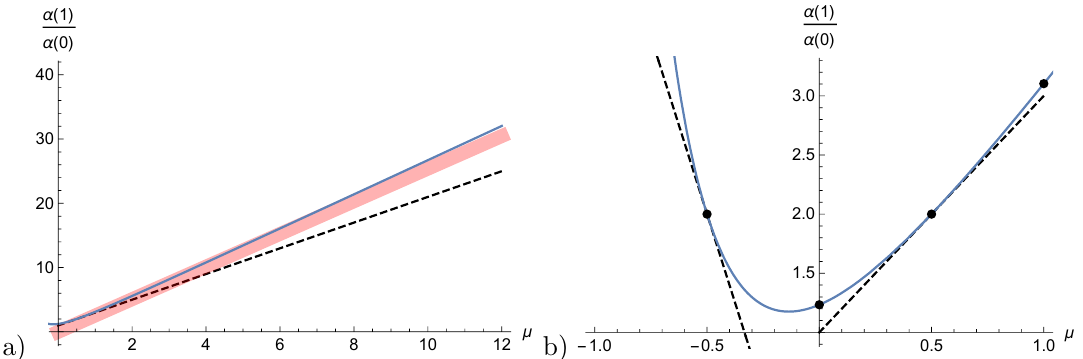
Figure 6 . A plot of (cid:11) (1) =(cid:11) (0) vs. (cid:22) . The solid blue line was computed numerically. The dashed black lines are tangents at (cid:22) = (cid:6) 1 = 2. The thick red line is the large (cid:22) saddle point approximation. The black dots are analytically computed points. (b) zooms in on the small (cid:22) region of (a). There is a minimum at approximately (cid:22) = (cid:0) 0 :